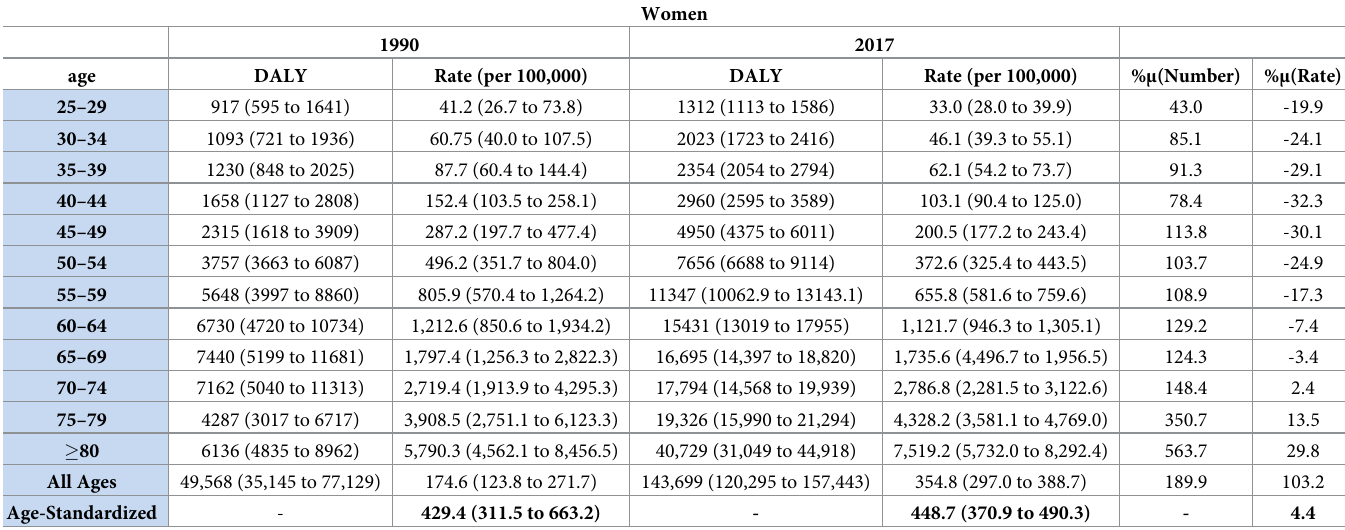
Table 4. DALY number and rate of HHD by age in women in 1990 and 2017 in